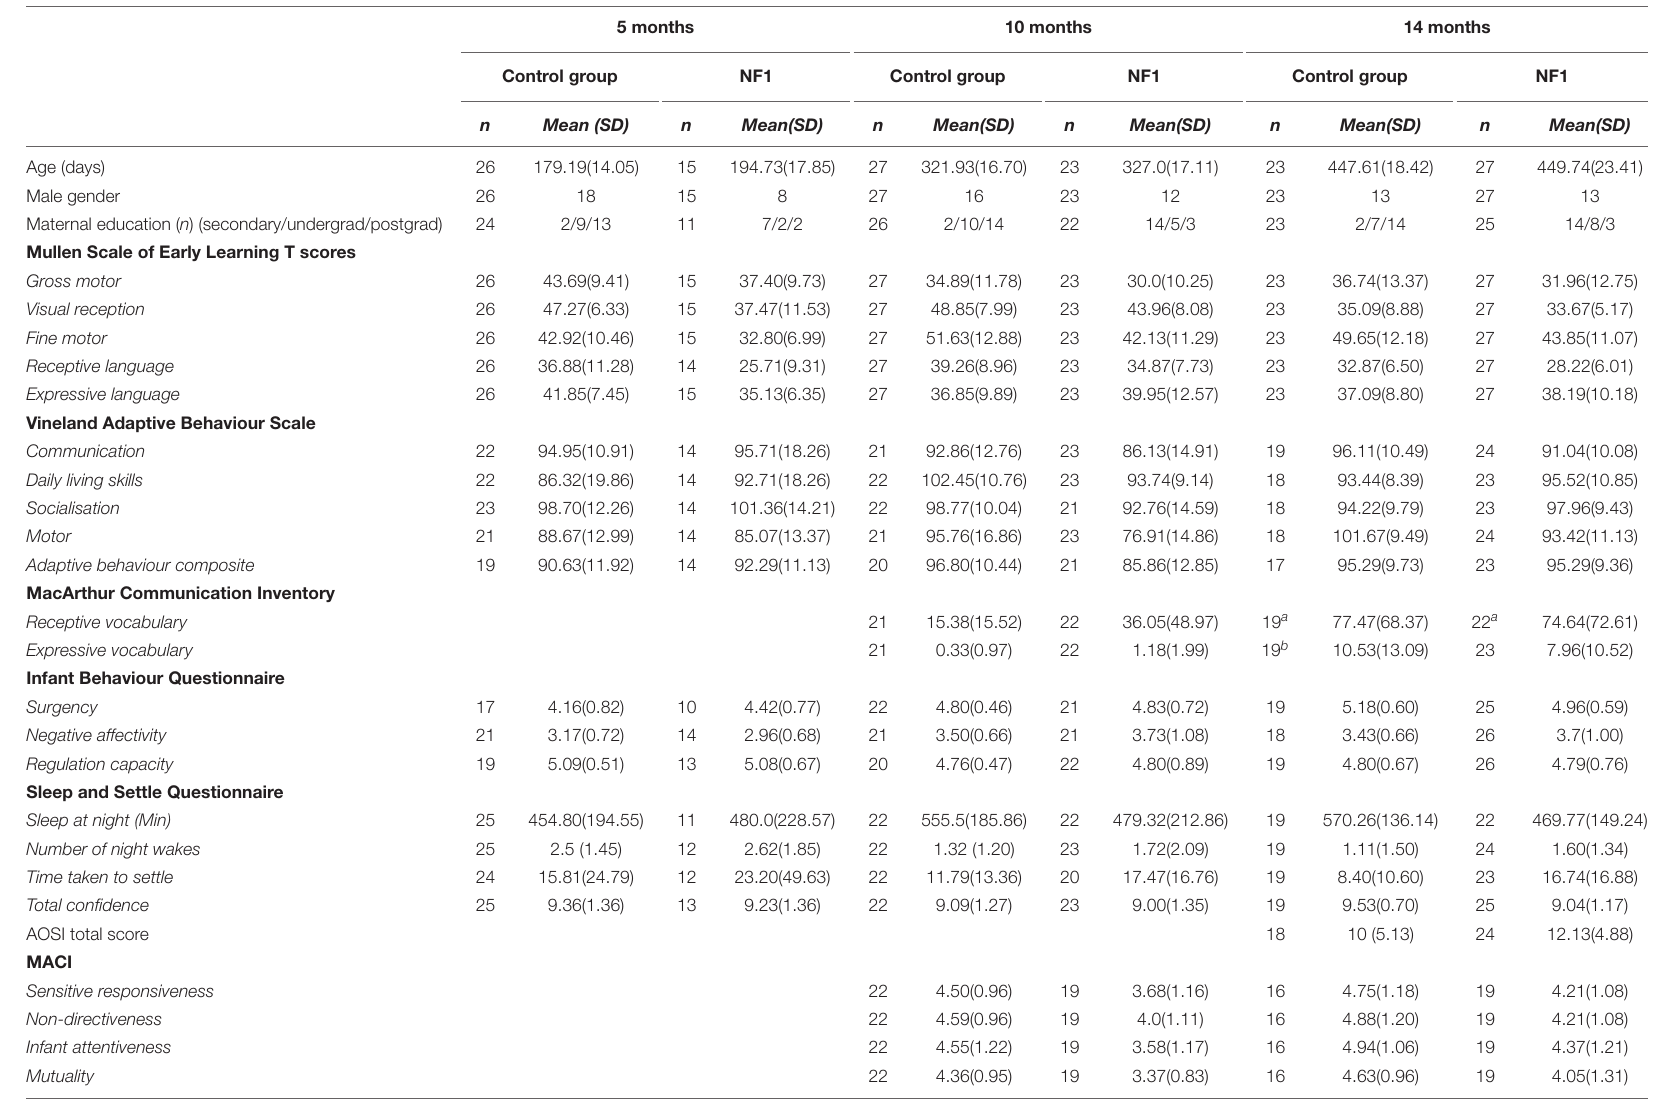
TABLE 1 | Descriptive statistics including means and SDs for the NF1 and control group at the three assessment time